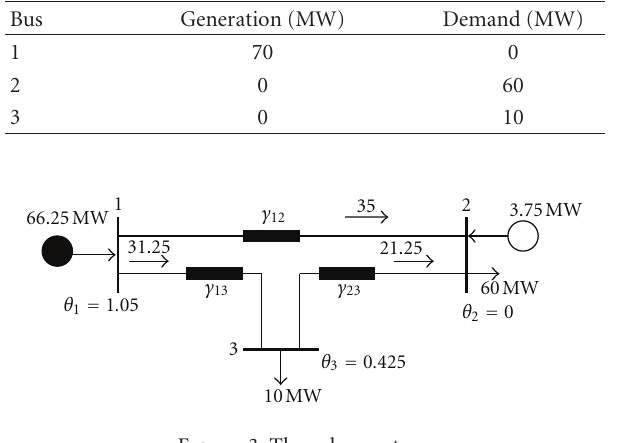
Figure 3: Three-bus system.